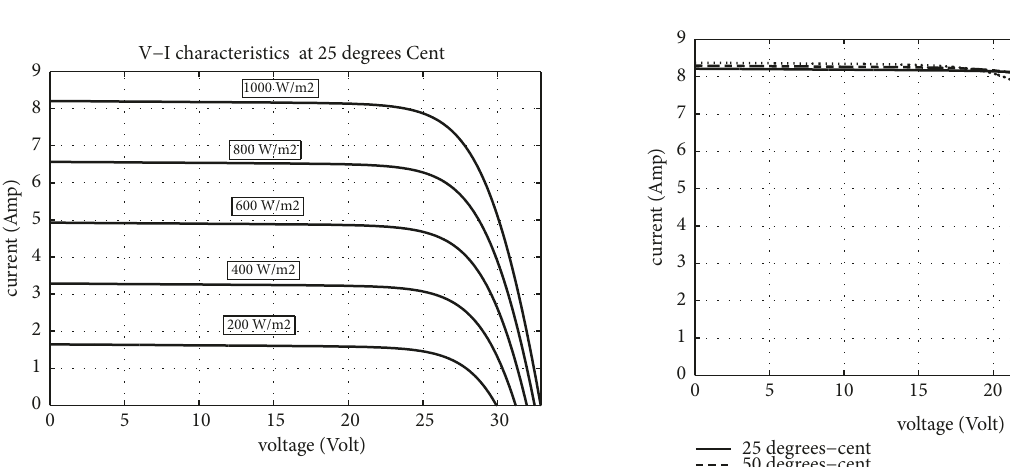
Figure 6: I–V model curves of the KC200GT solar module at different irradiations, 25 ∘ C.